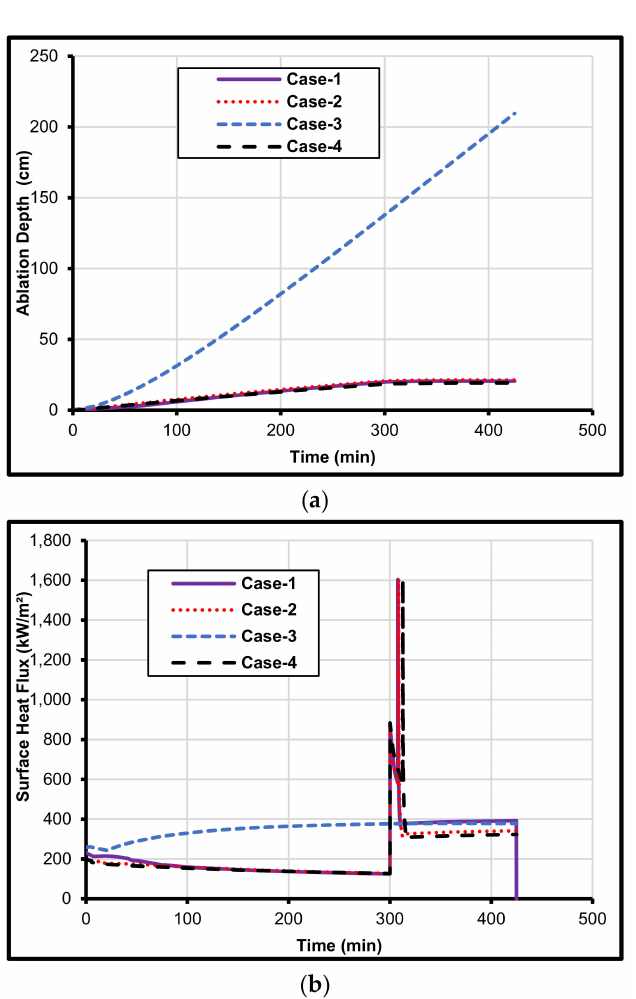
Figure 9. Effect of melt/corium composition during MCCI at 425 min on ( a ) ablation depth and ( b ) surface heat